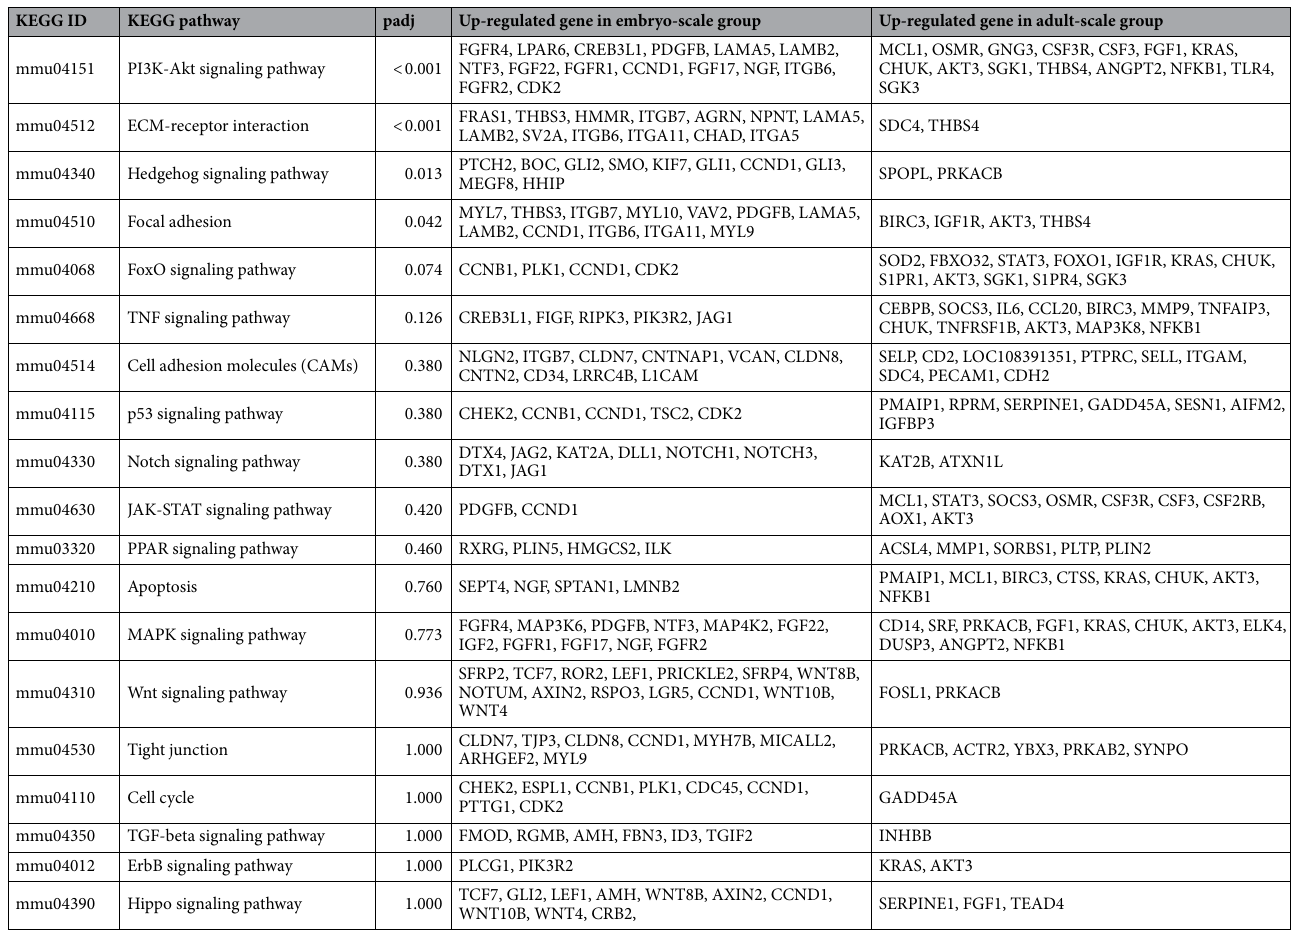
Table 2. KEGG signalling pathways related to skin appendage differentiation with DEGs between embryo- scale and adult-scale (embryo-scale vs adult-scale